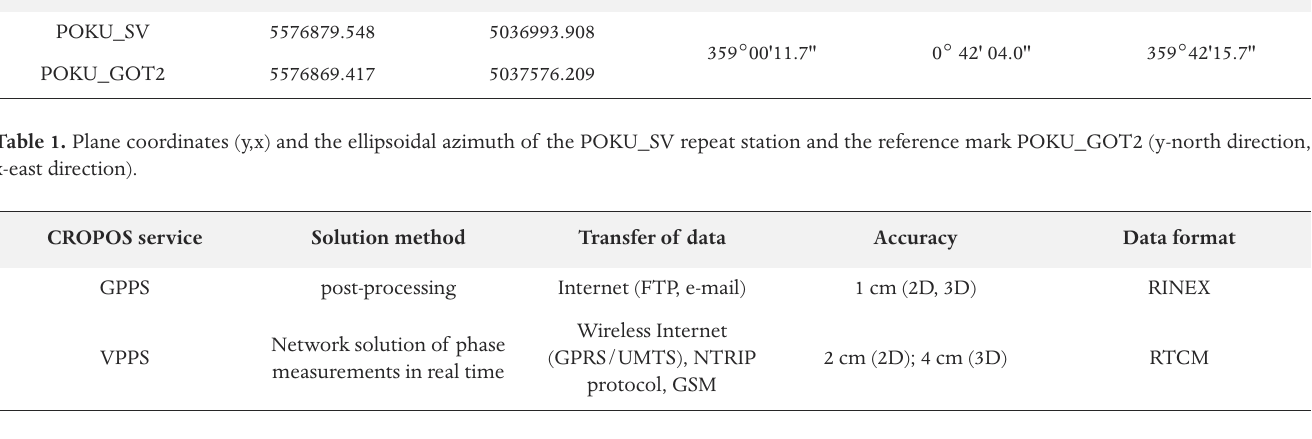
Table 2. Main characteristics of the CROPOS GPPS and VPPS services (http://www.cropos.hr/index.php?option=com_content&view=article&id=14& Itemid=9&lang=en).